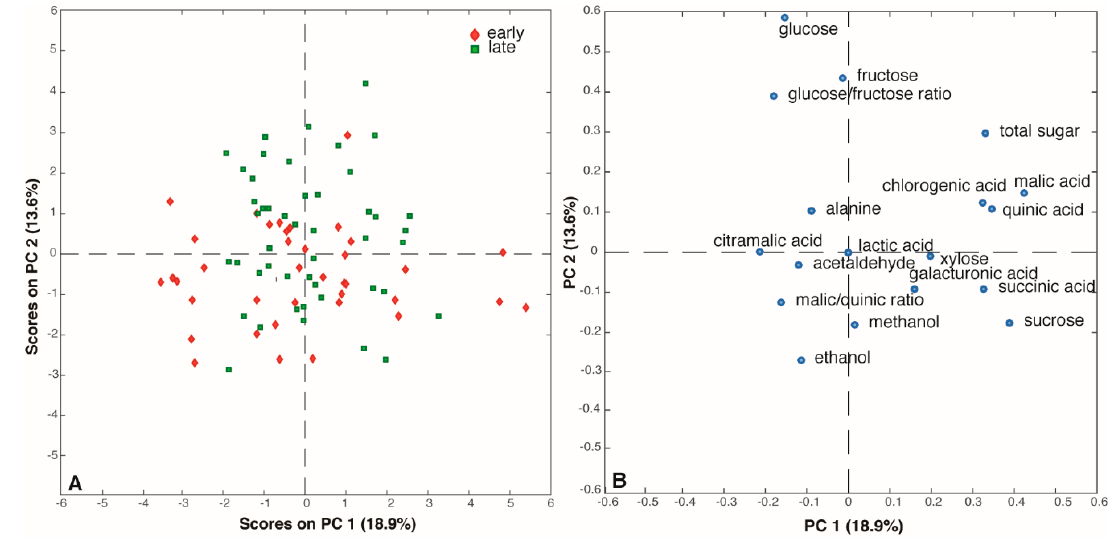
Figure 5. ( A ) Score and ( B ) loading plots of the PCA performed on the Bruker SGF profiling dataset.